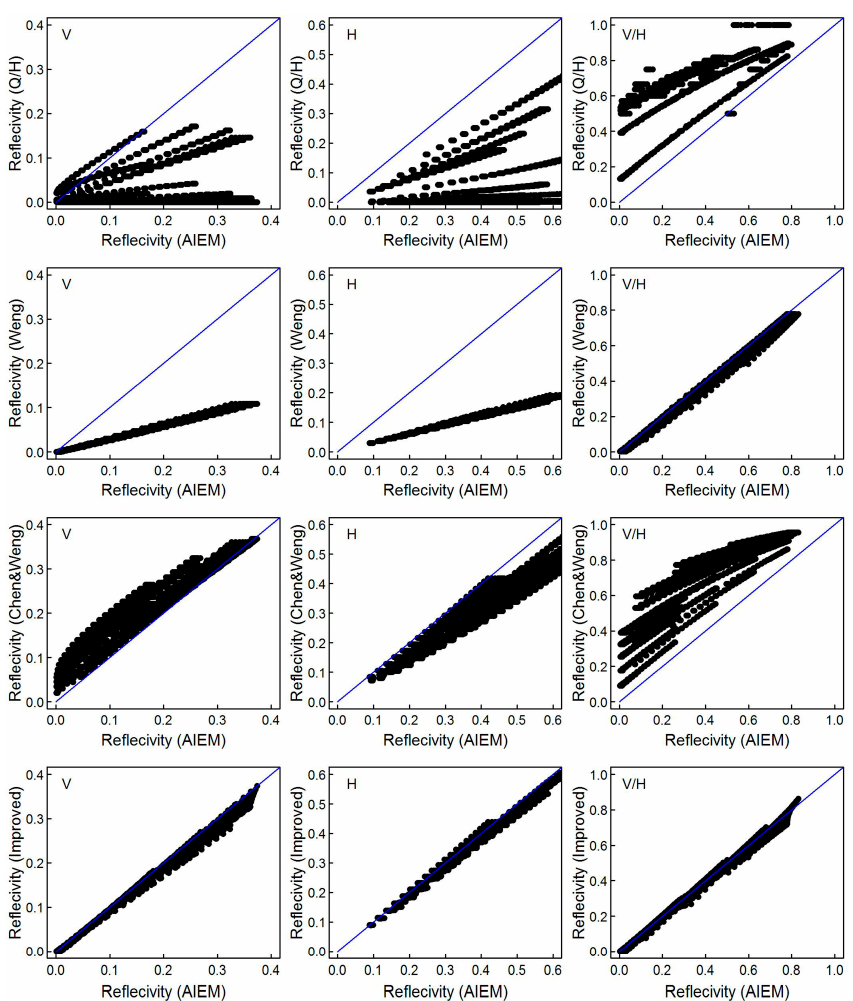
Figure 4. Comparison of the effective reflectivity between the AIEM simulations and the corresponding calculations using the Q / H , Weng, Chen and Weng, and the parameterized soil surface emissivity model for vertical ( V ) polarization, horizontal ( H ) polarization, and the ratio of the two polarizations ( V/H ) based on the parameters listed in Table 1 at 10.7 GHz.